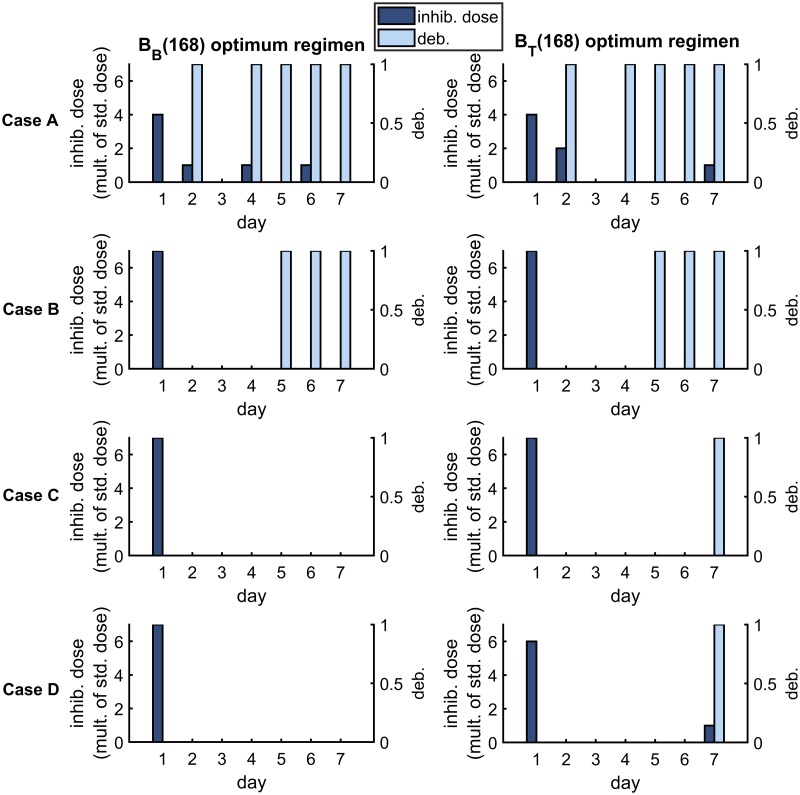
Optimum treatment regimens—minimising final bacterial burdens with an established infection.For each parameter set (rows) the optimum regimen of inhibitor doses and debridement is shown, where we minimise either the final number of bound bacteria, BB(168) (left-hand column), or the final total number of bacteria, BT(168) (right-hand column). Note that inhibitor treatments are plotted as multiples of the standard dose (6.12×107 inhib. cm−3). Using most or all of the inhibitors on the first day is optimal in Cases B–D, whereas inhibitor doses should be distributed across the week in Case A. It is optimal to debride on most days in Case A, on the last three days in Case B and either once on the last day (BT(168) optimum) or not at all (BB(168) optimum) in Cases C and D. Eqs 1–11 were solved using ode15s, with a constant antibiotic dose. Parameter values: A = 8 μg ml−1, λ = 0 cm3cell−1hr−1, ρ = 0 hr−1 and ω = 1. The initial conditions are the untreated steady-states for each parameter set, modified so that 2% of the free and bound bacteria are resistant. See Tables 2–4 for the remaining parameter values.